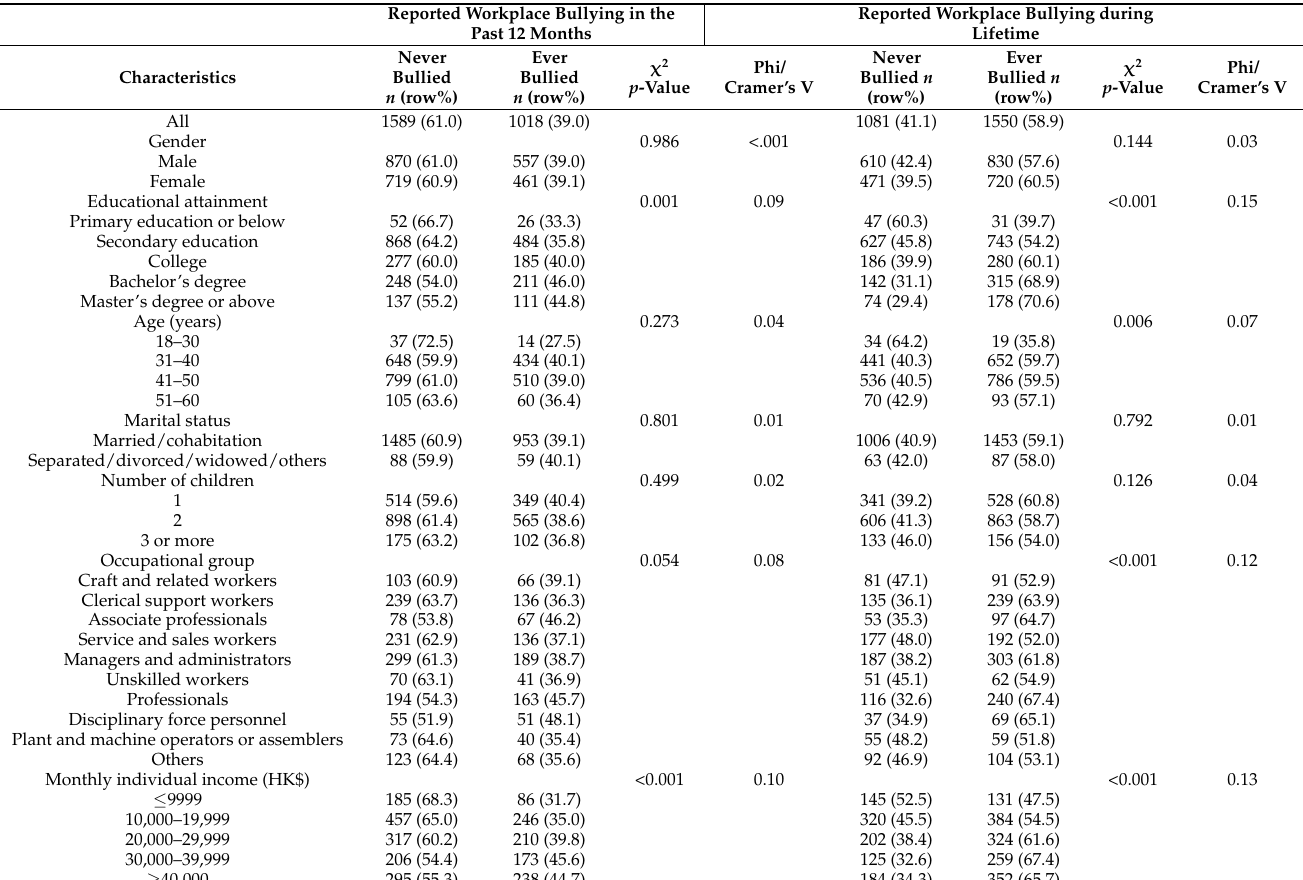
Table 2. Demographic characteristics of respondents and exposure to workplace bullying.